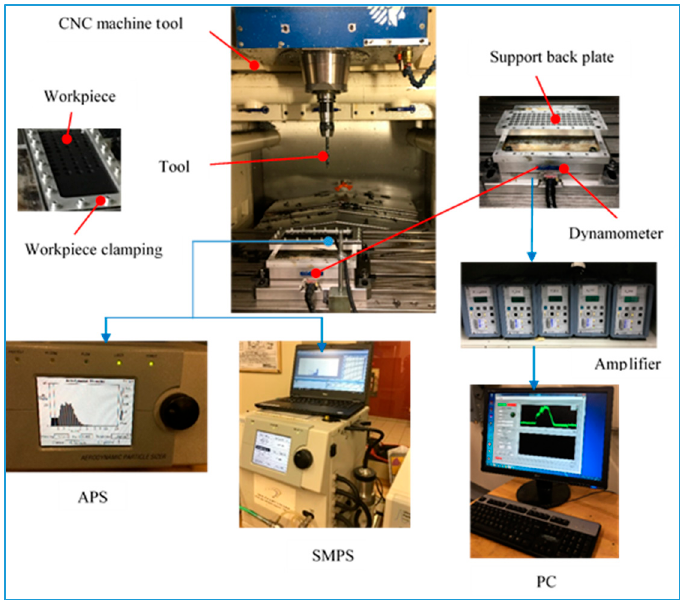
Figure 2. The experimental devices for machining and measurement system. Figure 2 . The experimental devices for machining and measurement system .